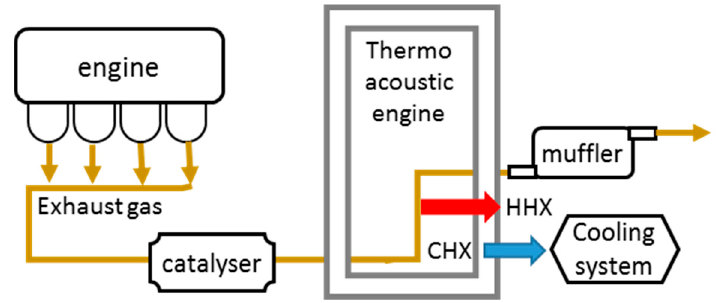
Figure 2. Sketch of the system to recover energy from the exhaust gas of a combustion engine using a loop-branched Stirling-type cycle generator (TA-SLiCE) and showing the heat exchange through the Hot and Cold Heat Exchanger (HHX and CHX respectively).